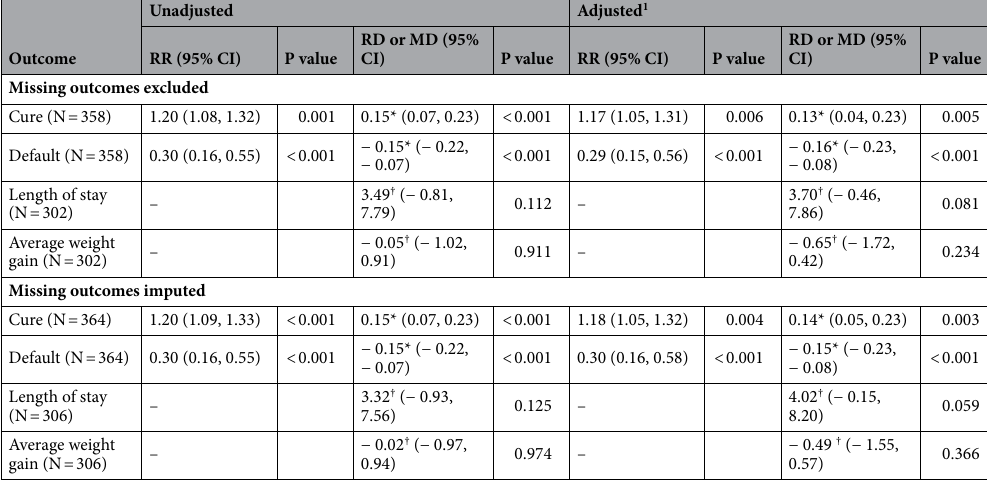
Table 3. Effect of the intervention on treatment outcomes. RR: Risk ratio; RD: Risk difference; MD: Mean Difference. 1 Adjusted for wealth index, exposure to HIV, and fever. * Risk difference. † Mean difference. The effects of the intervention on transfer, death and no response were not evaluated because of the small number of cases.